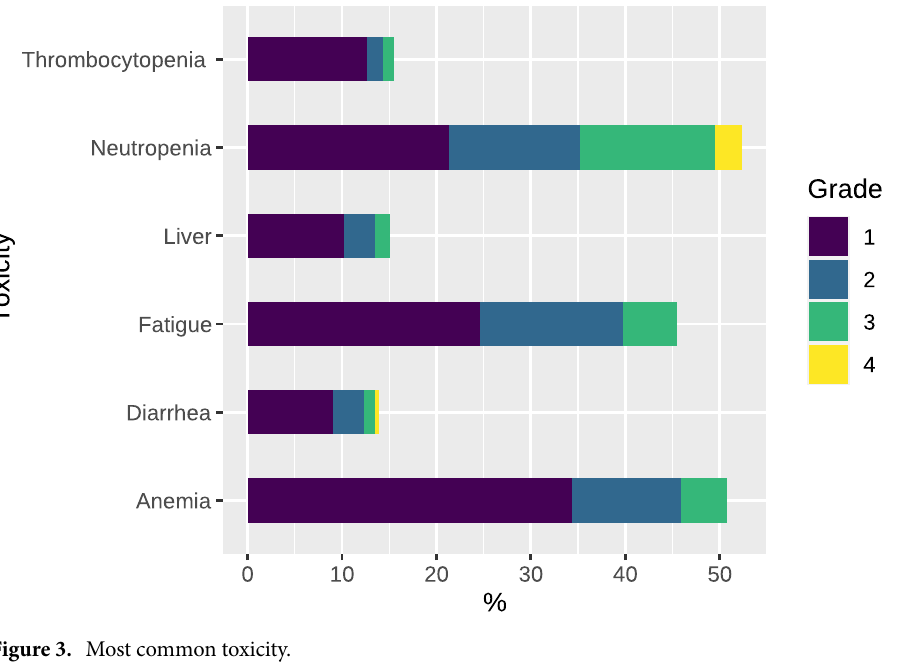
Figure 3. Most common